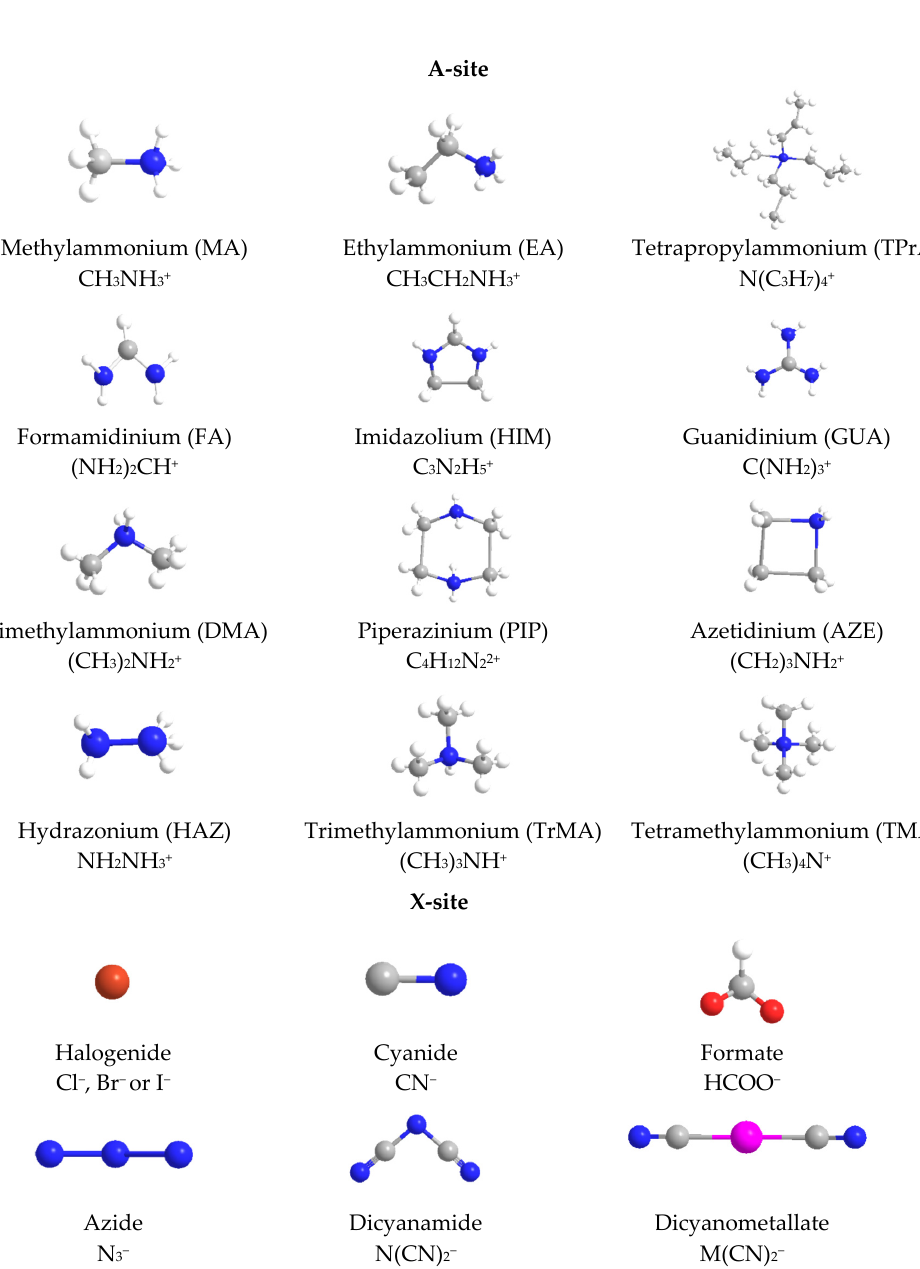
Figure 2. A-site and X-site ions of hybrid organic-inorganic perovskites. Adapted from reference